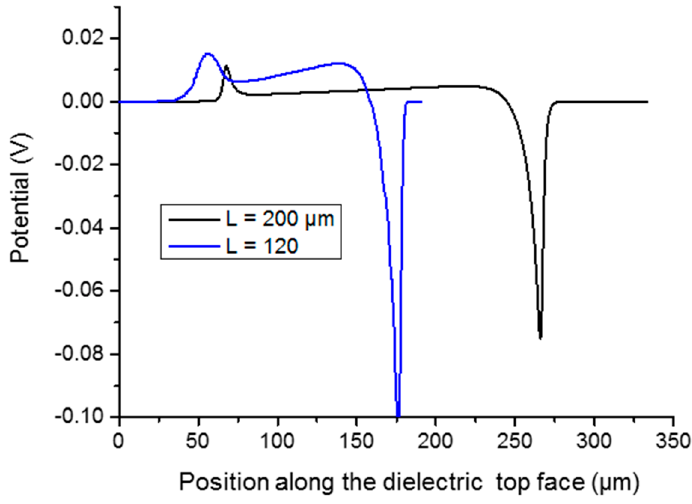
Figure 5. Calculated potential along the top dielectric facet with L = 120 and 200 µm long wires embedded in h = 2 µm dielectric layer with α = 1 ° conicity angle and ρ = 10 cm curvature radius bending.